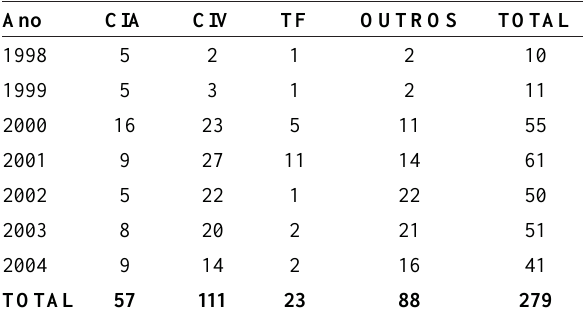
Outros procedimentos incluíram: defeito septal atrioventricular, operação de Blalock-Taussig, coarctação da aorta. CIA- comunicação interatrial. CIV- comunicação interventricular. TF- tetralogia de Fallot.